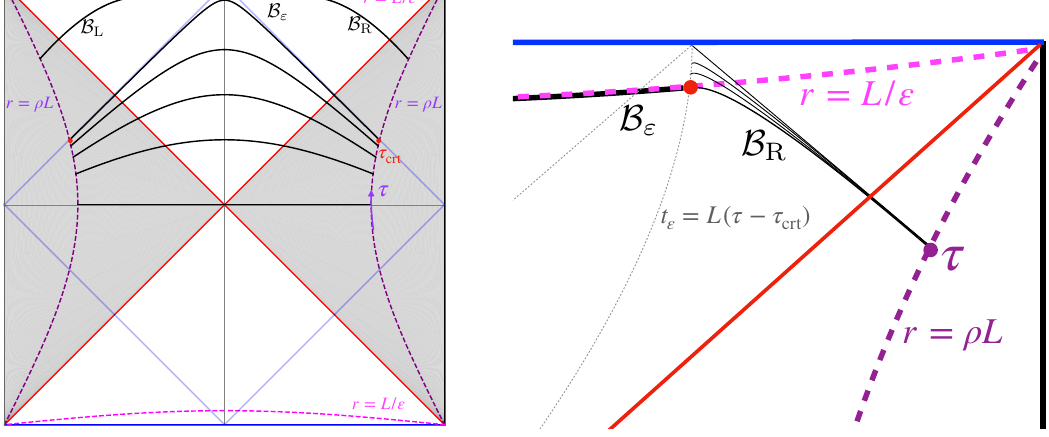
Figure 12 . Left: the time evolution of the extremal surfaces for evaluating C transition time τ crt , we consider hypersurfaces B which are defined piecewise and do not extend beyond the cutoff surface at r = r max = L/ε . They consist of three parts, i.e., B = B Right: part of Penrose diagram with zooming into the late time regime at τ > τ crt . The black curves anchoring on the stretched horizon at r = ρL are various candidate surfaces ranging from B being null to where it connects being tangent to B ε . The position of the intersection of B R B ε along the cutoff surface is denoted by t ε = L τ ε